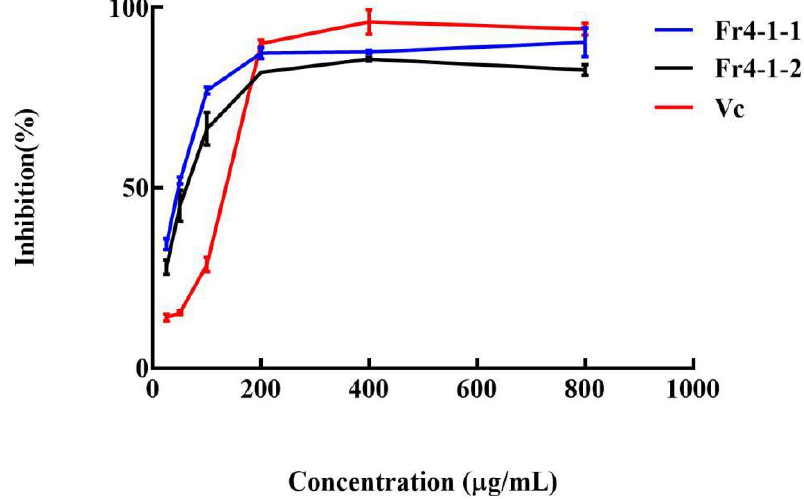
Figure 7. Antioxidant capacity of compounds Fr4-1-1, Fr4-1-2 and vitamin C.